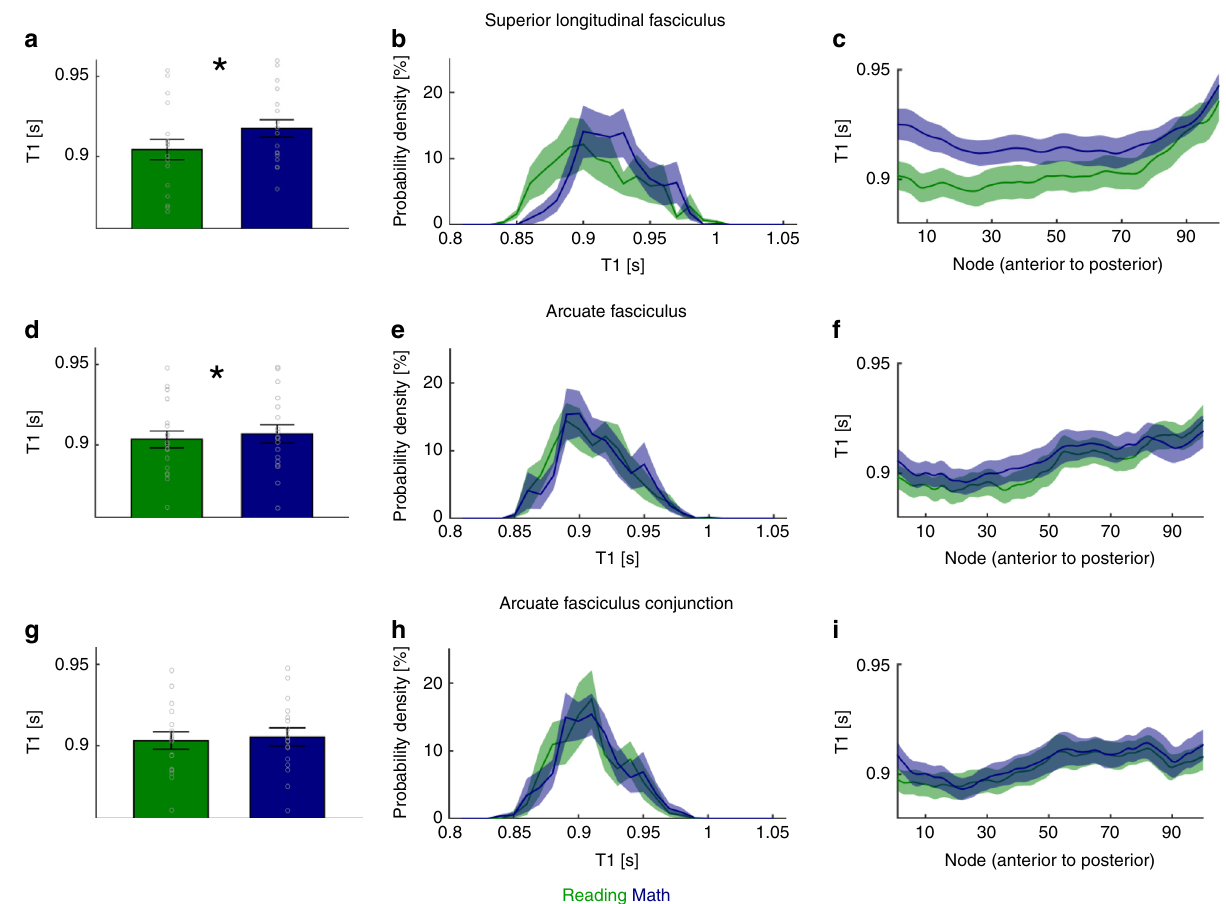
Fig. 5 Tracts in the SLF and the AF that are associated with reading show shorter proton relaxation time (T 1 ) than those associated with math. a – c : T 1 measurements for SLF tracts connecting IFG and SMGr in the reading network (green) and PCS and SMGm in the math network (blue). d – f : T 1 measurements for AF tracts connecting the IFG and STS in the reading network (green) and the PCS and ITG in the math network (blue). g – i : T 1 measurements for AF tracts connecting the lOTC conjunction fROI with the IFG in the reading network (green) and the PCS in the math network (blue). Left a , d , g : Average T 1 for reading- and math-related tracts in the SLF and the AF. Bar graph shows mean across subjects± SEM. Circles: Individual subjects ’ data. Asterisk: T 1 for math- and reading-related tracts differs signi fi cantly, p < 0.05 (paired t -test). Middle b , e , h : Distribution of T 1 values. The histograms show the distribution of T 1 values across all nodes in each subject ± SEM. Right c , f , i : Average T 1 for reading- and math-related tracts along the SLF and the AF. Line graph shows mean across subjects± SEM. IFG inferior frontal gyrus, PCS precentral sulcus, SMGr reading fROI in supramarginal gyrus, SMGm math fROI in supramarginal gyrus, STS superior temporal sulcus, ITG inferior temporal gyrus, lOTC lateral occipito-temporal cortex, SLF superior longitudinal fasciculus, AF arcuate